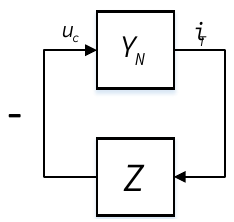
Figure 3. Feedback interconnection of Z and Y N